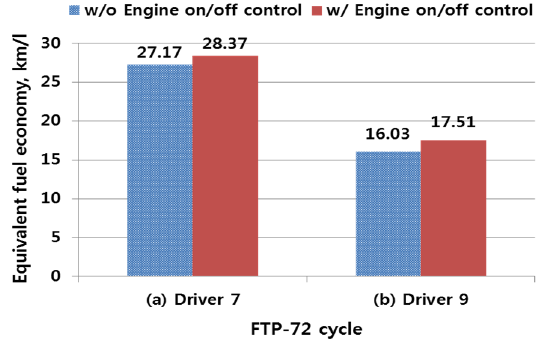
Figure 13. Comparison of equivalent fuel economy for the engine on/off control. ( a ) Driver 7; ( b ) Driver